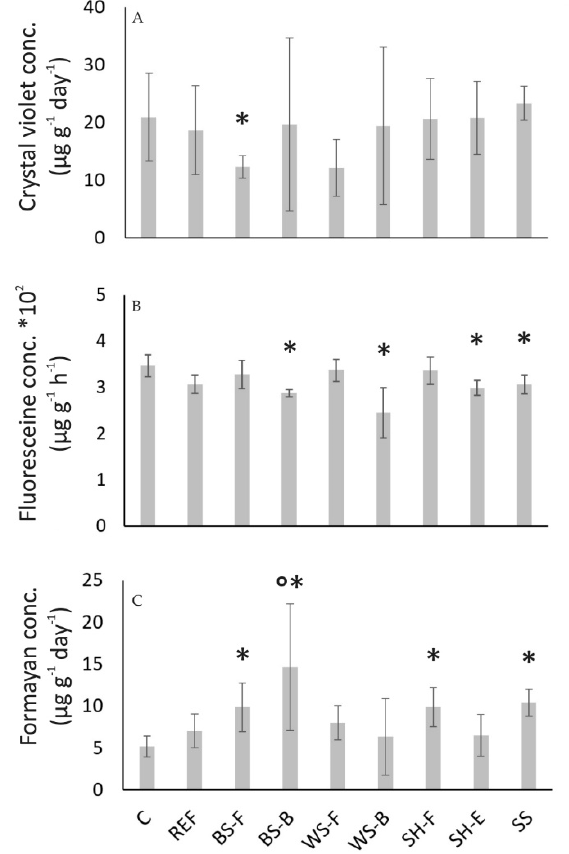
Figure 7. Biofilm forming ability ( A ), fluorescein diacetate activity ( B ), and dehydrogenase activity ( C ). Asterisk mark a statistically significant difference of the treatment compared to control. Circle mark a statistically significant difference of the treatment compared to the reference. All tests were significant if p < 0.05.